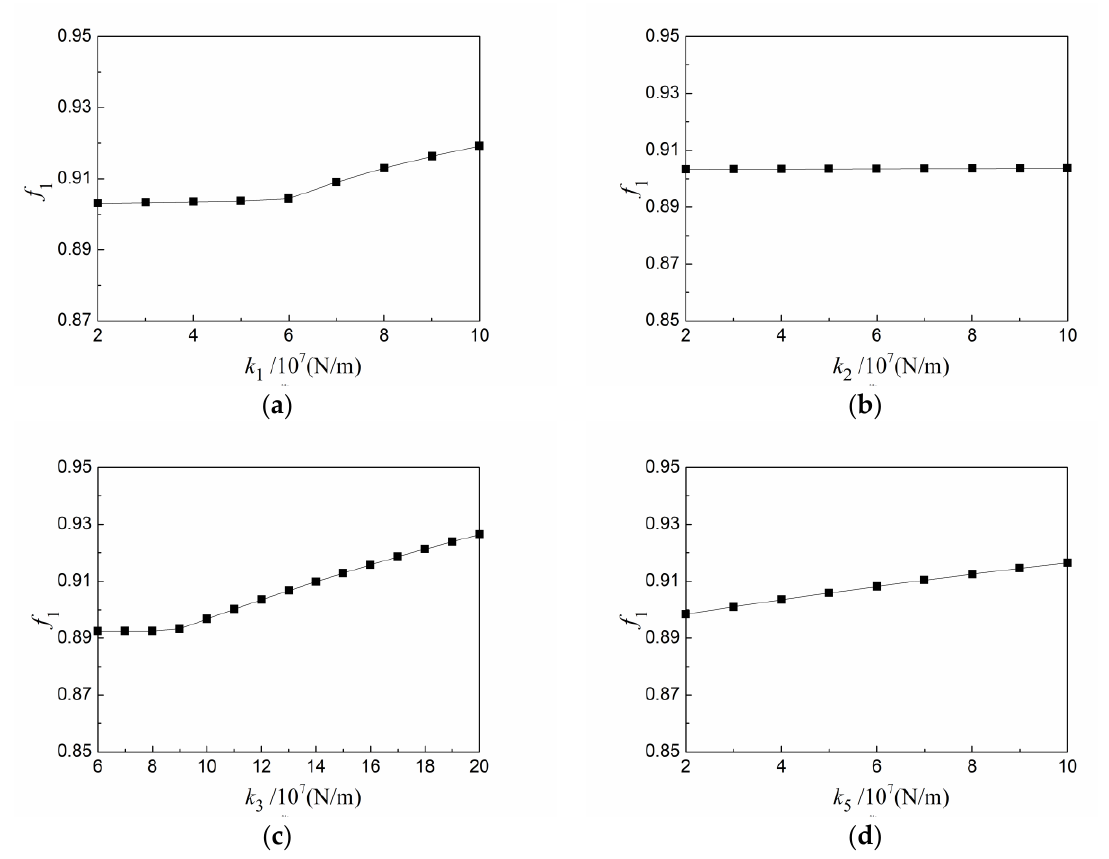
Figure 13. Effect of stiffness change of each support on f 1 . ( a ) Effect of support 1 stiffness on f 1 ; ( b ) effect of stiffness of support 2 on f 1 ; ( c ) effect of stiffness of support 3 on f 1 ; ( d ) effect of stiffness of support 5 on f 1 .